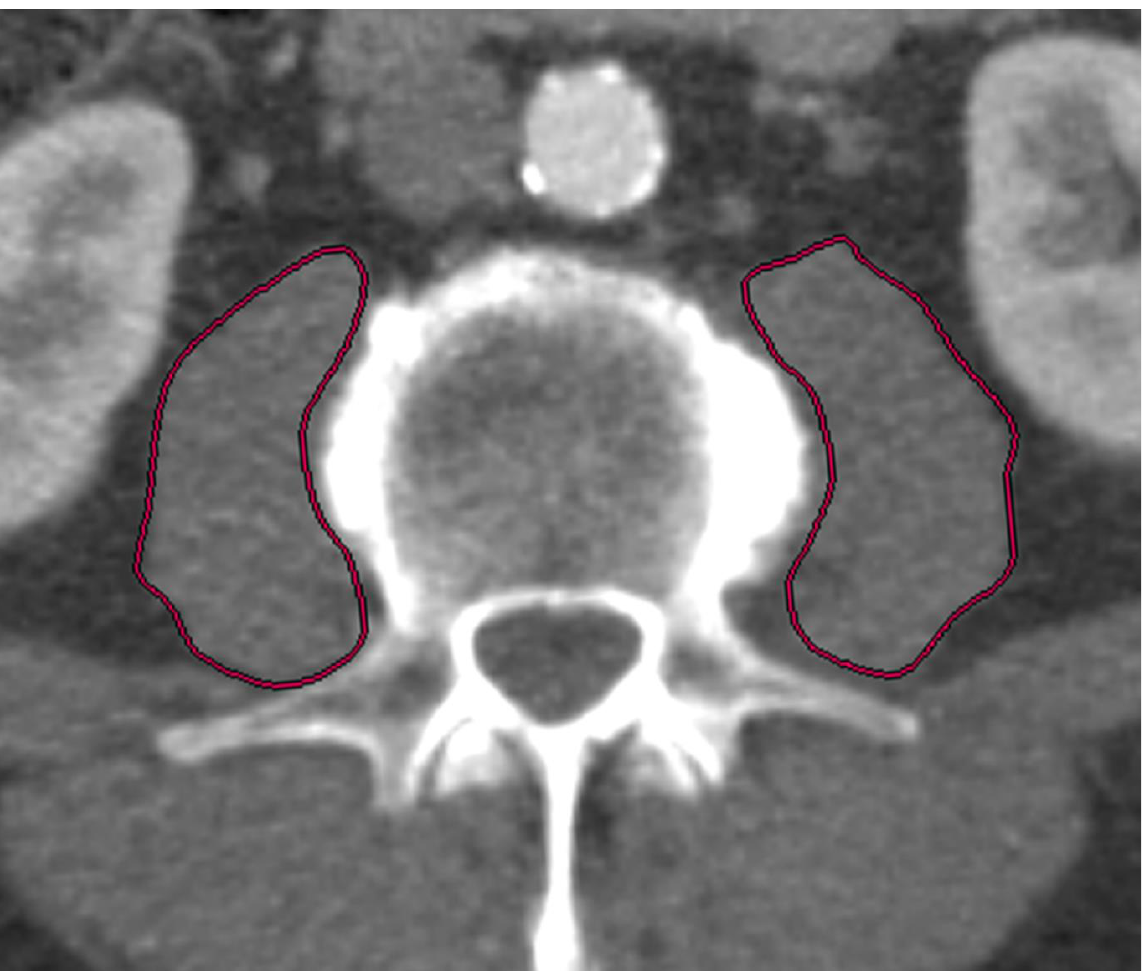
Figure 2. Measurement of left and right Psoas muscle area (PMA) by manually outlining the psoas muscle perimeter (different patient to Figure 1) on an axial slice obtained as demonstrated in Figure 1. The sum of left and right muscle areas normalized to body surface area yielded PMAi.